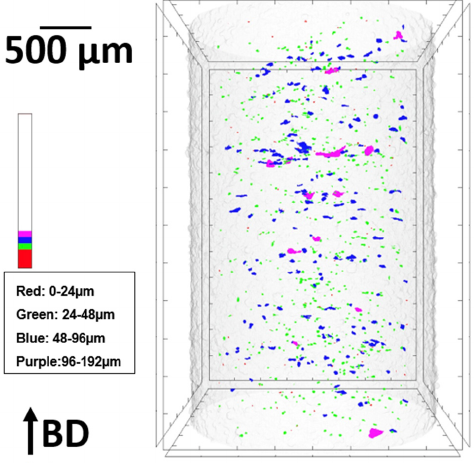
Figure 5. μ -CT image presenting the 3D pore distribution of the as-built sample (red: 0–24 μ m, green: 24–48 μ m, blue: 48–96 μ m, purple: 96–192 μ m). BD is the build direction.